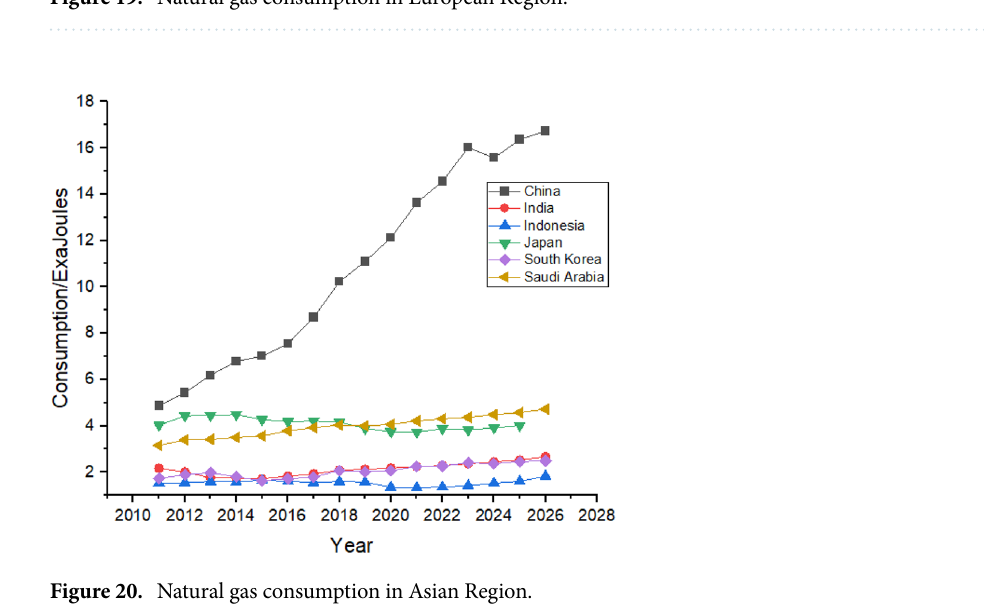
Figure 19. Natural gas consumption in European Region.